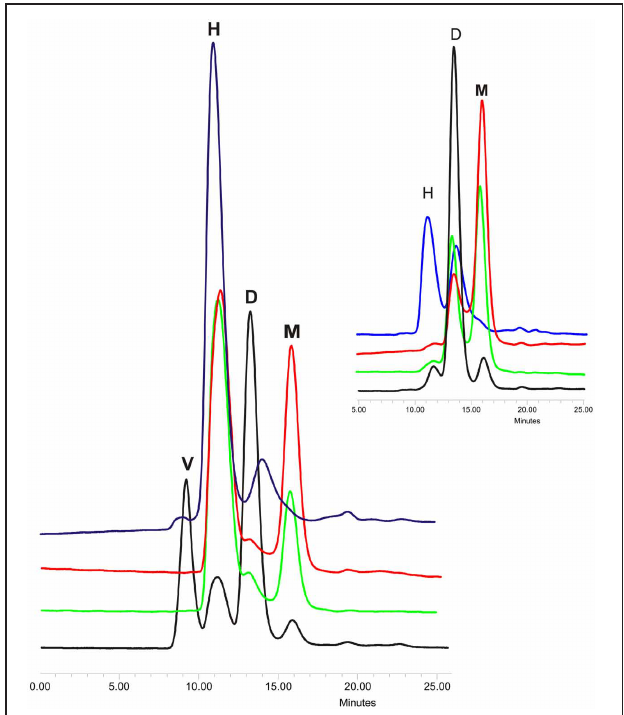
FIGURE 3 | Gel filtration of oligomerized hCC wt (black) and its hinge loop mutants: V57D (green), V57N (red), and V57P (blue). Protein samples were incubated in 50mM AcONa (pH 4.0), 100mM NaCl at 48 ◦ C for 2h with constant mixing and subjected onto Superdex 75 column equilibrated in the same buffer. In the inset chromatograms of the protein samples before incubation are presented. Peak descriptions: M , monomeric hCC; D , dimeric (domain swapped) hCC; H , putative hexameric hCC assembly; V , higher hCC oligomers eluted in the void volume of the column. The SEC elution profiles are given for a better illustration of the data described in Szyma´nska et al. (2008).